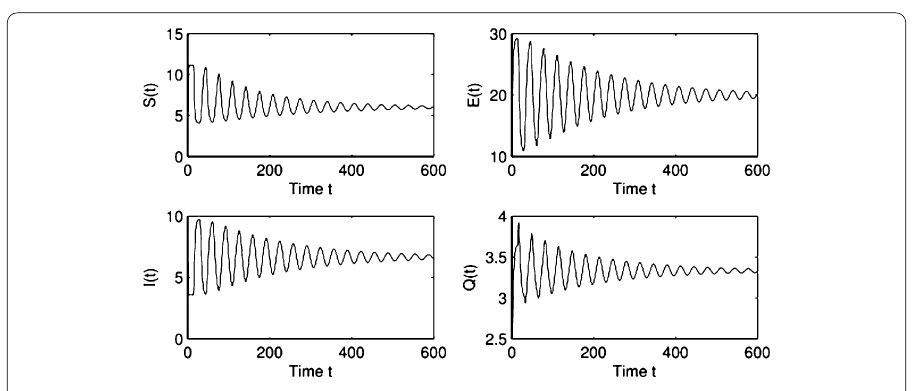
Figure 6 P ∗ is stable periodic when τ = τ 0 = 13.9858